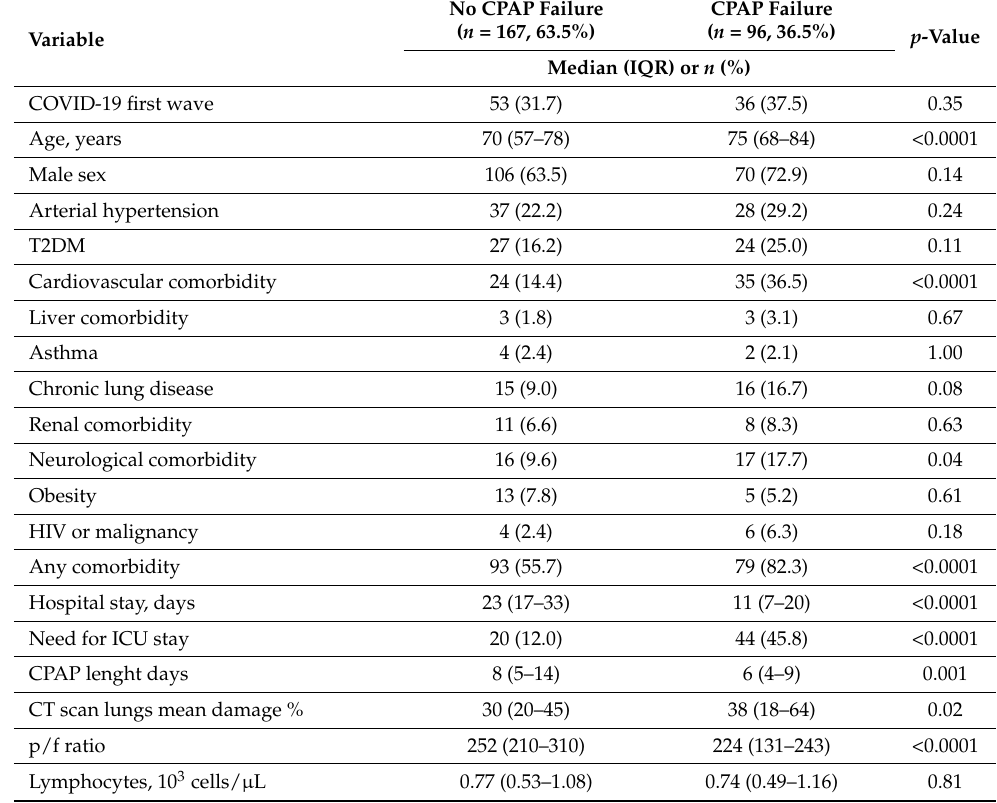
Table 4. Characteristics of the COVID-19 population treated with CPAP: comparison between CPAP failure and no CPAP failure